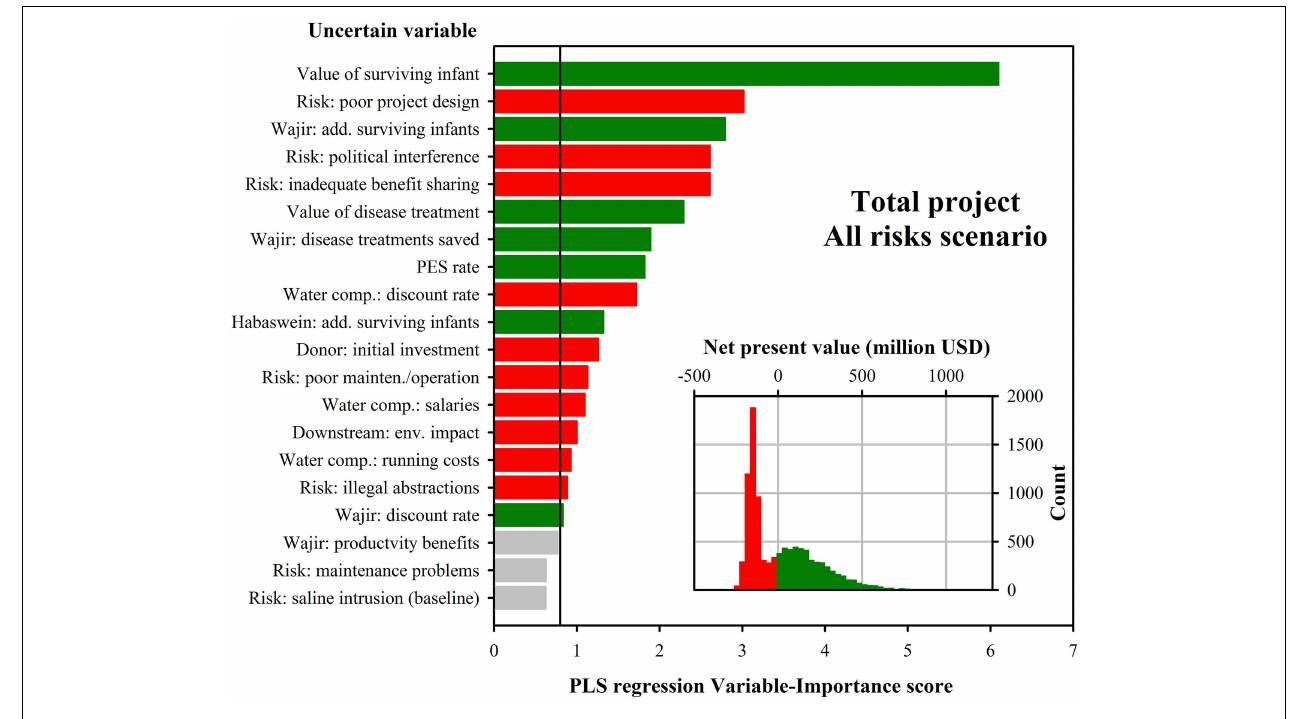
FIGURE 5 | Key sources of uncertainty in projecting outcomes of the overall project for the “all risks” scenario, as identified by Partial Least Squares (PLS) regression. Bars show the Variable-Importance- in-the-Projection statistic, with high values indicating that uncertainty about the variable is a major source of uncertainty in model outputs. Green bars in